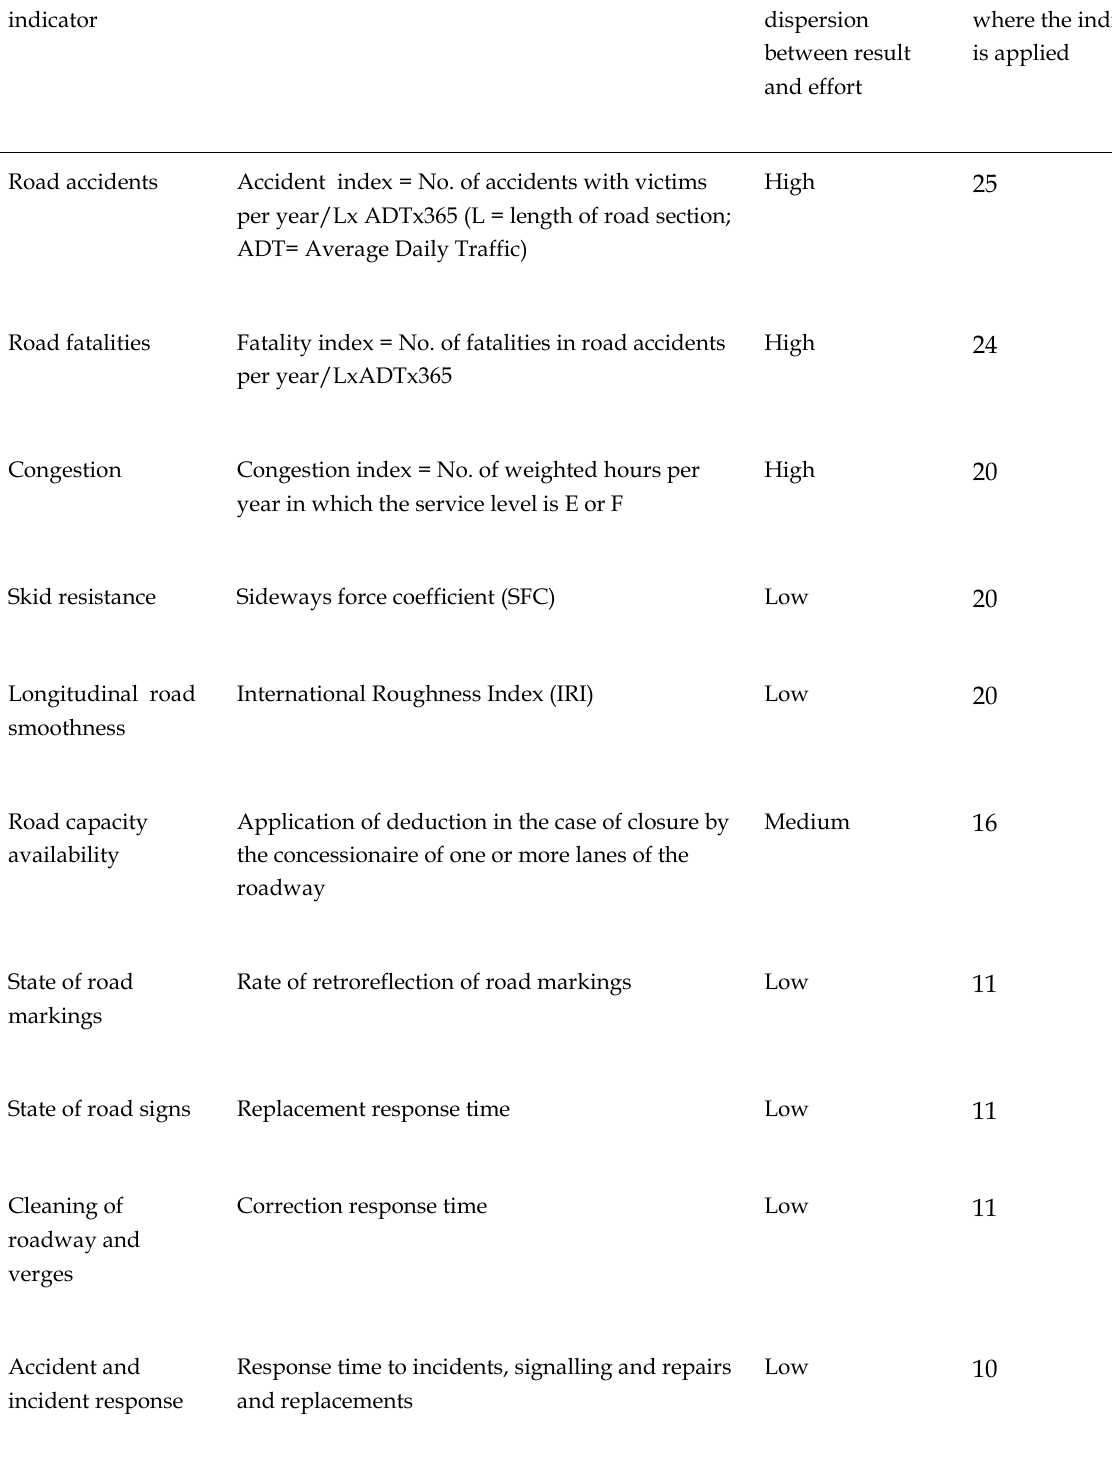
Table 1. Use of performance indicators in Spanish road